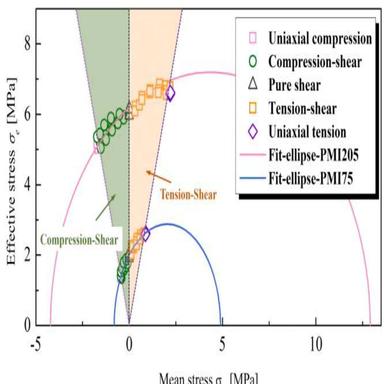
The initial yield surfaces of PMI foam materials with densities of 0.075 and 0.205 g/cm3 . The open scatters denote the experimental data of Mises and mean stresses and each open scatter corresponds to one test. The solid blue and pink curves are the fitting yield surface of PMI foam material with densities of 0.075 g/cm3 and 0.205 g/cm3 , respectively (For interpretation of the references to color in this figure legend, the reader is referred to the web version of this article.).